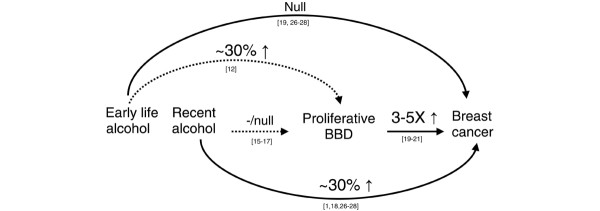
Schematic description of relation between alcohol consumption, proliferative benign breast disease (BBD), and breast cancer. Solid lines indicate well-established associations and dotted lines indicate less-established relations.